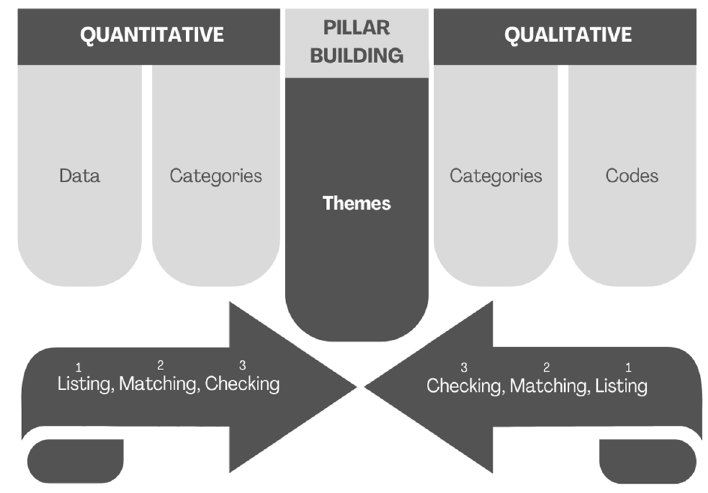
Figure 1. Pillar Integration Process [53].